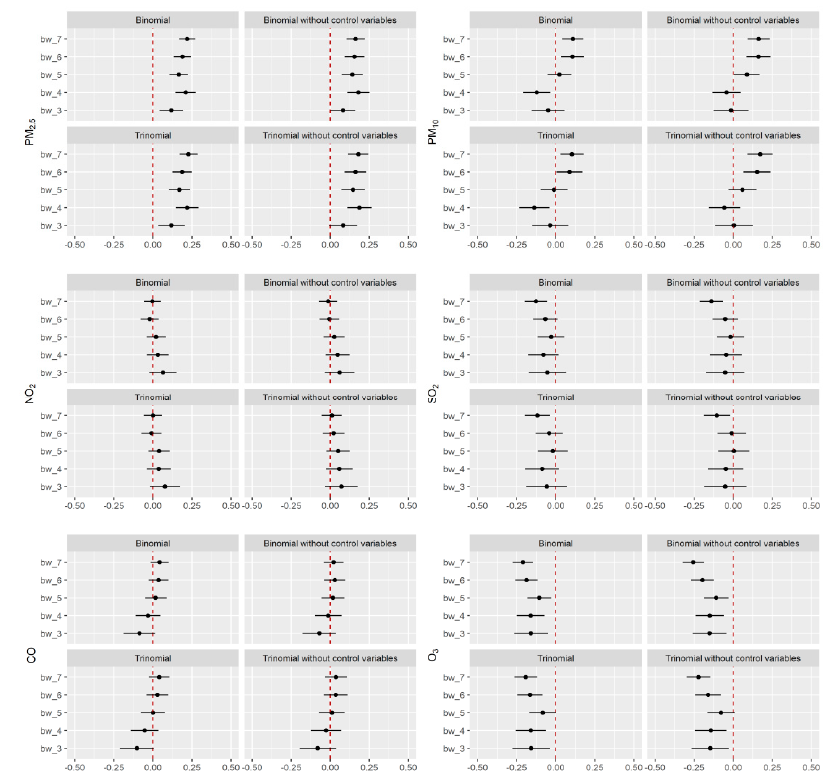
Figure 2. Robust